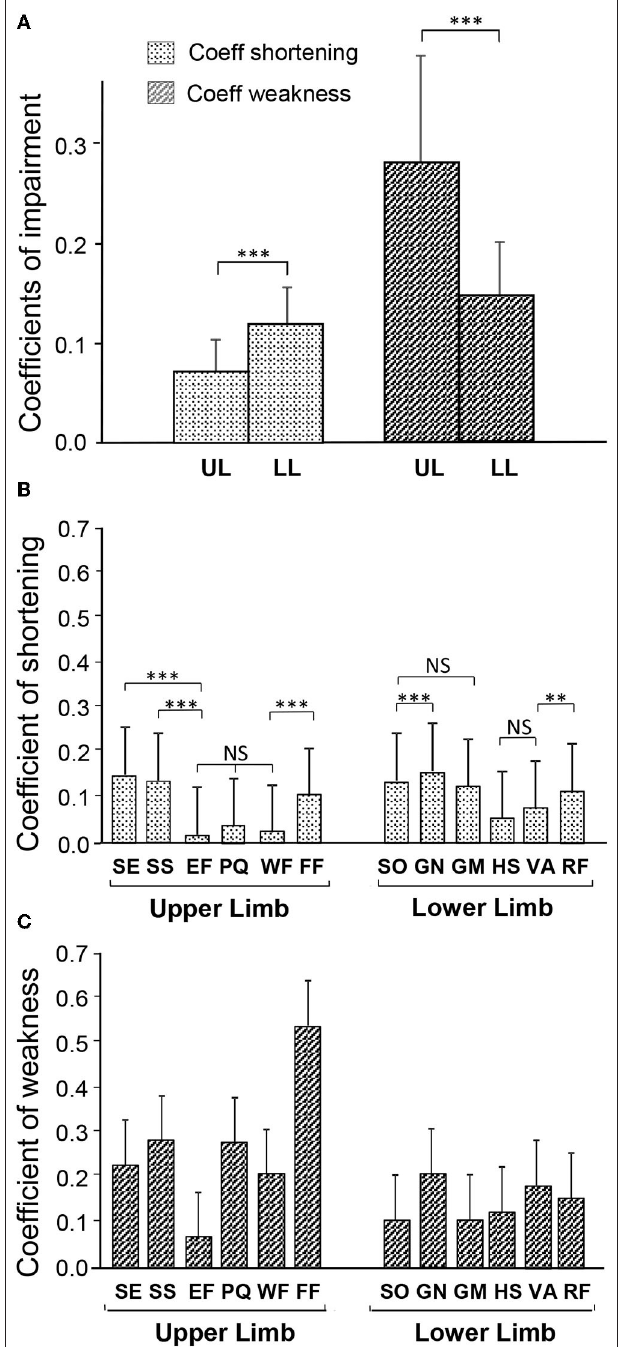
FIGURE 3 | Degree of muscle shortening and of motor command impairment in chronic hemiparesis. (A) Coefficients of impairment of the Composite score of the upper and lower limbs. (B) Coefficient of Shortening of each of the investigated muscles. (C) Coefficient of Weakness of each of the investigated muscles. SE, shoulder extensor; SS, subscapularis; EF, elbow flexors; PQ, pronatus quadratus; WF, wrist flexors; FF, finger flexors; SO, soleus; GN, gastrocnemius; GM, gluteus maximus; HS, hamstrings; VA, vastus; RF, rectus femoris. ** p < 0.01; *** p <